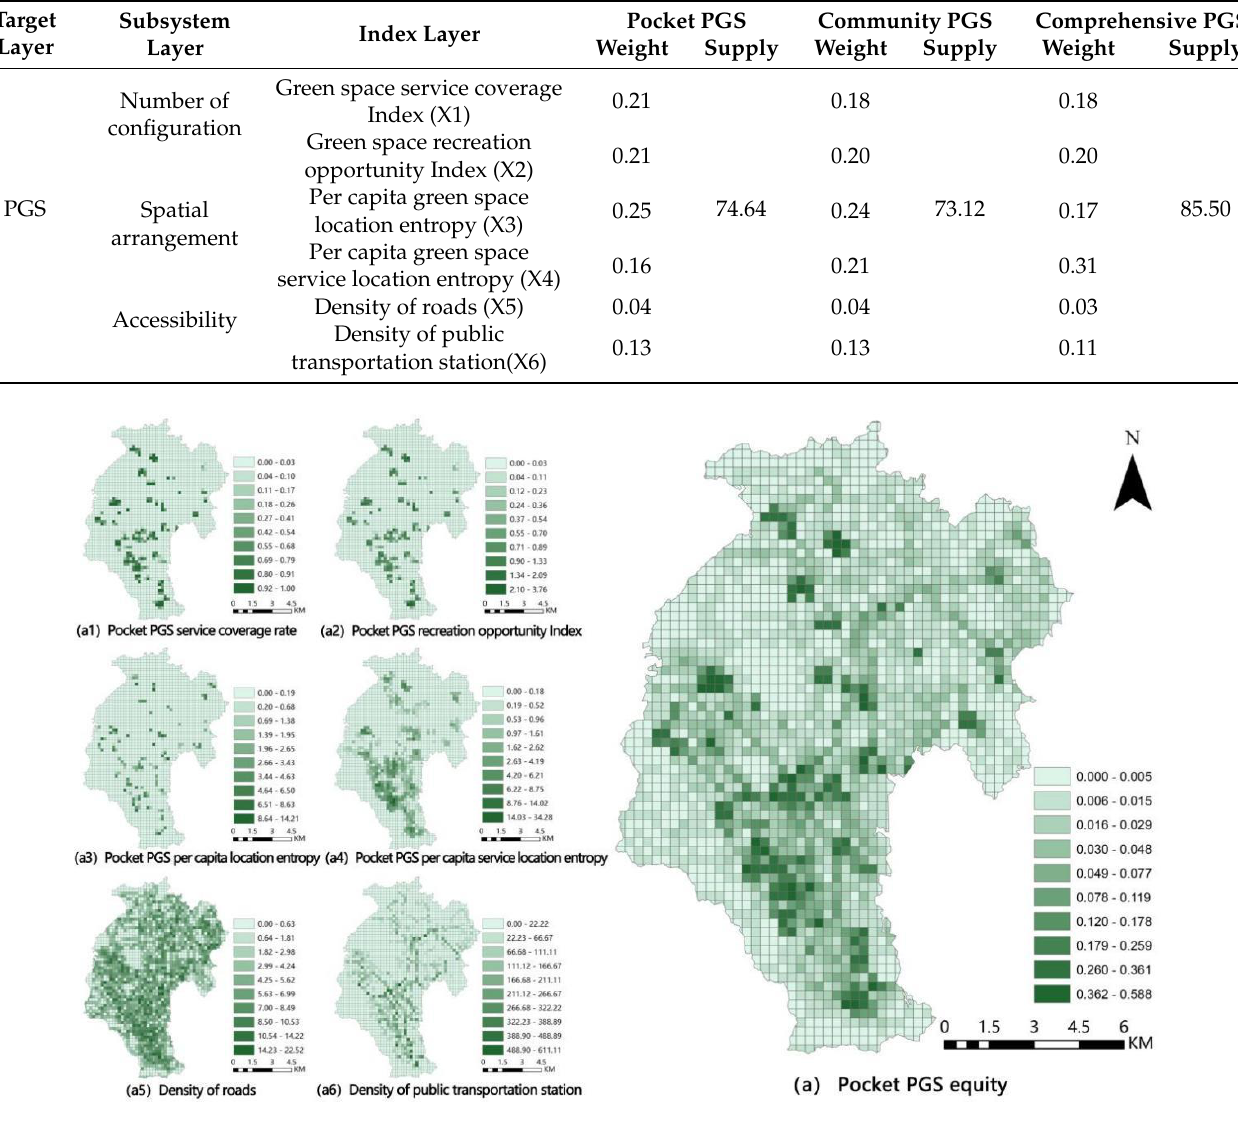
Figure 3. Equity indexes of pocket PGS.